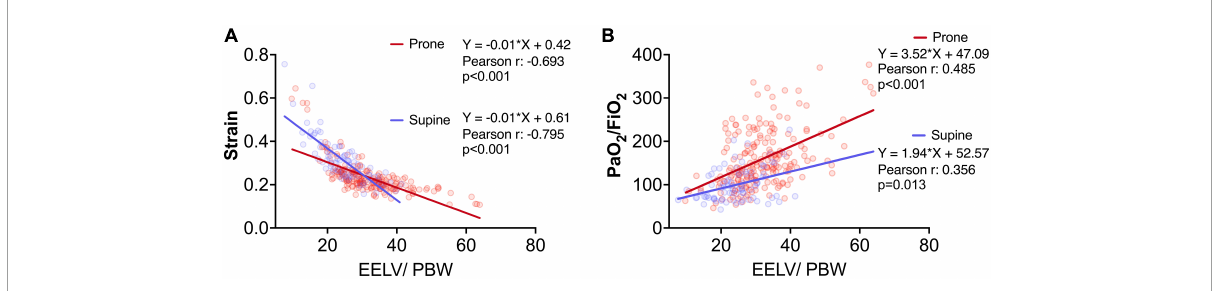
FIGURE2 Association between end-expiratory lung volume/Predicted body weight (EELV/PBW – ml/kg) versus strain (A) and PaO 2 /FiO 2 (B) ( n = 280). Blue and red circles represent measurements during supine and prone position, respectively. Equations, Pearson correlation coefficient and p -value were reported. Measurements were adjusted by robust clustering for each study patient.